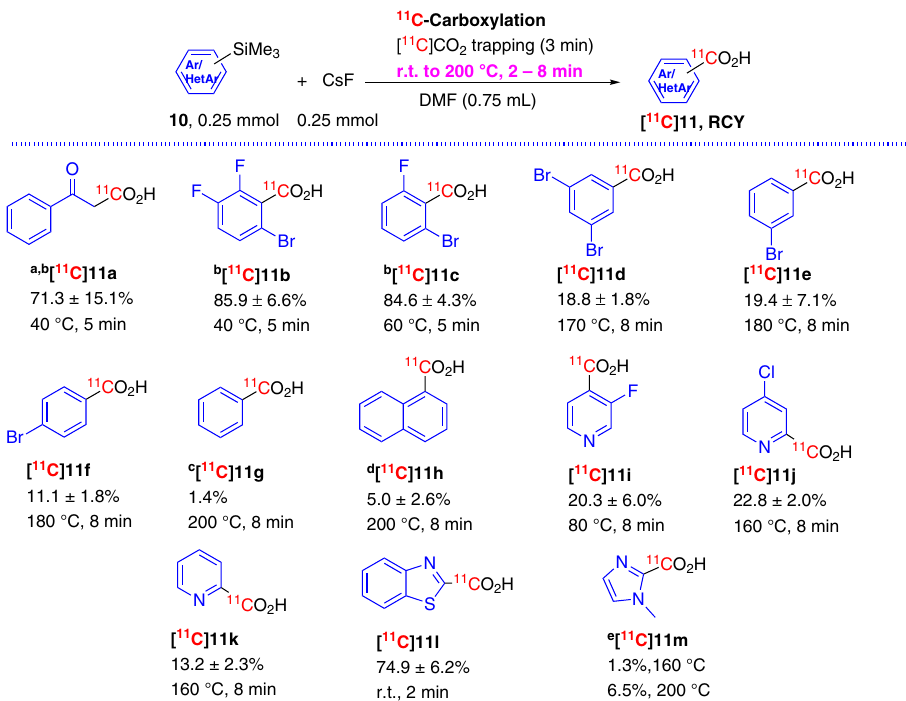
Fig. 3 FMDS 11 C-carboxylation with sp 2 -hybridized carbon attached trimethylsilanes. a Solvent DMF (0.25mL) + THF (0.5 mL), precursor is sp 2 - hybridized carbon attached silyl enol ether; b Precursors are highly moisture sensitive; c There was no detected product at 150 and 160 °C; d Precursor 10 mg (0.05 mmol) in DMF (0.3 mL) ( n = 4 for RCC); e tert -Butyldimethylsilyl attached 1-methylimidazole was used as precursor; there was no product detected at 120 °C, 8 min for all